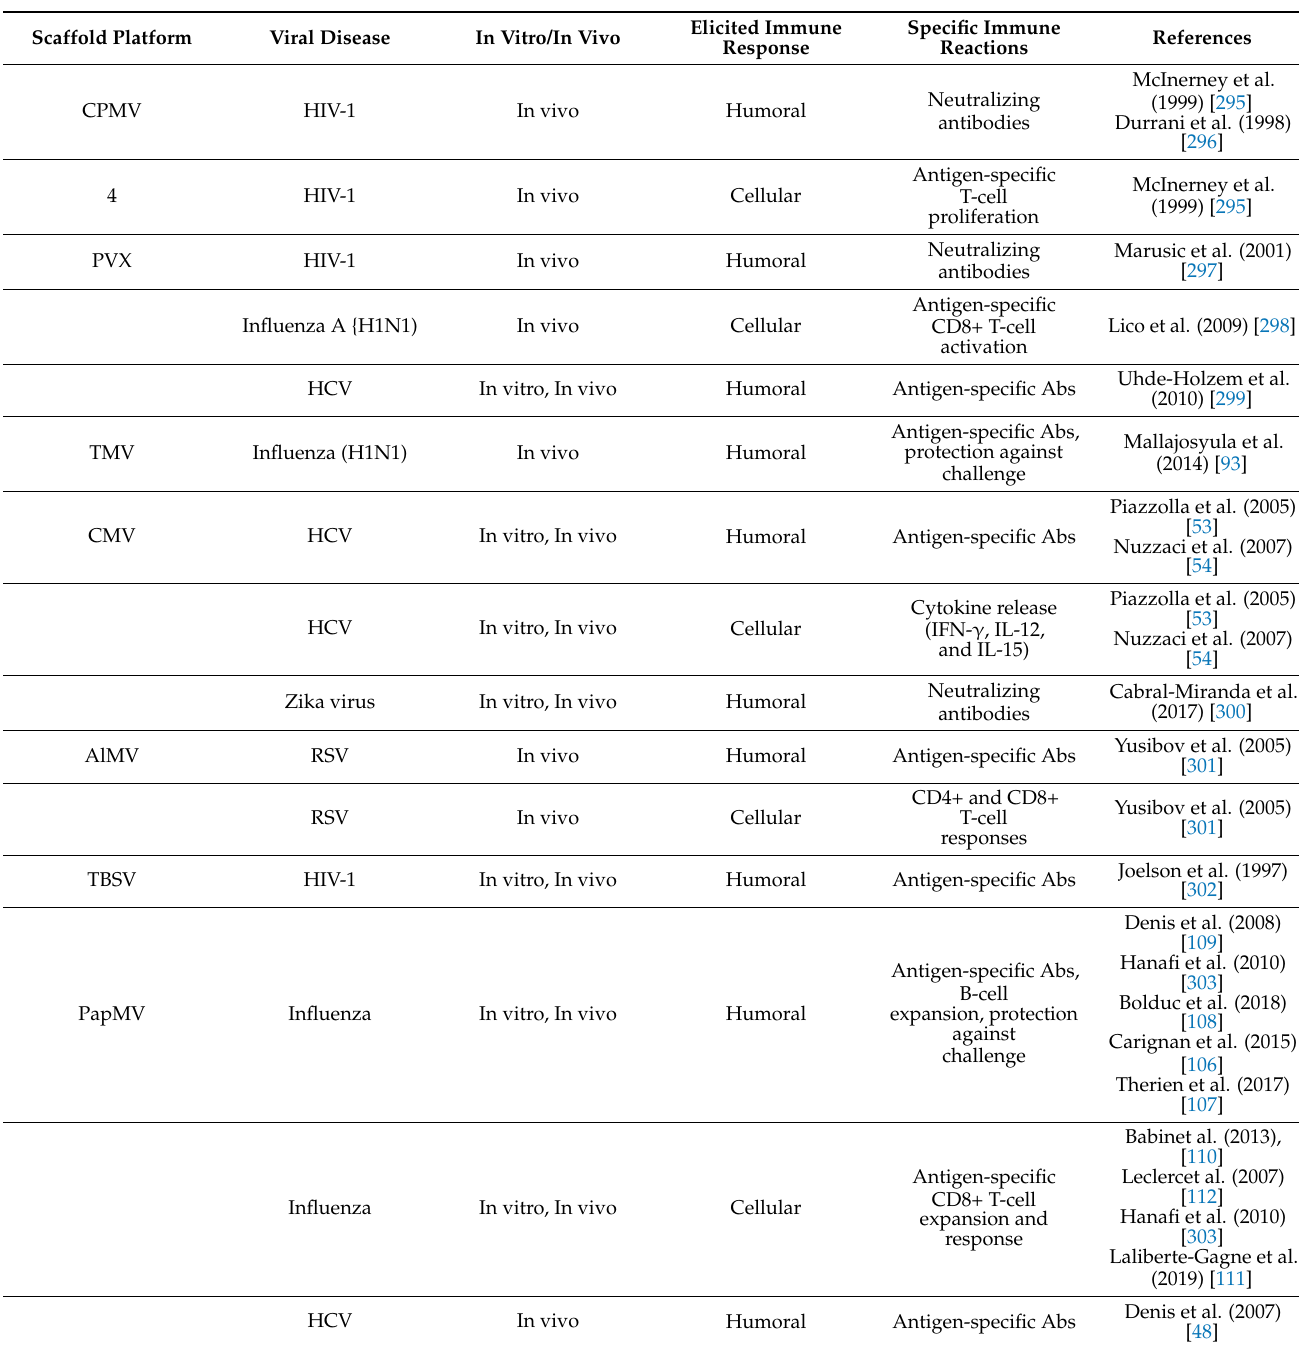
Table 3. Immune reactions induced by plant virus-derived protein nanoparticle (VNP) vaccines. Scaffold